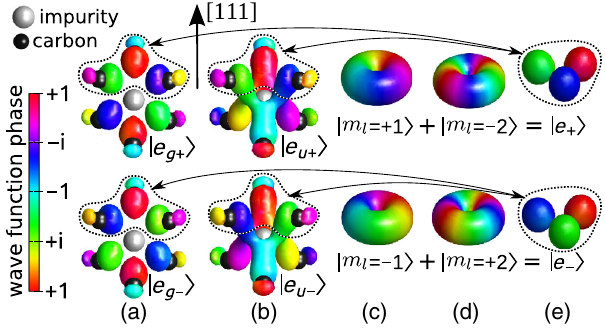
FIG. 8. Isosurfaces represent the phase of (a) e orbitals, g (cid:2) (b) e orbitals of SiV ð − Þ qubit from side view ( z axis parallel to u (cid:2) 1 wave functions, and (d) m ∓ 2 [111] direction), (c) m l ¼ (cid:2) l ¼ wave functions. Linear combinations of (c) + (d) (admixtures of 1 and n ¼ 3 l ¼ 2 m ∓ 2 orbitals) atomic n ¼ 2 , l ¼ 1 m l ¼ (cid:2) l ¼ can result in (e) e or e − orbitals very similar to that obtained in þ (a) and (b). The sign of the wave function does not change for ( g